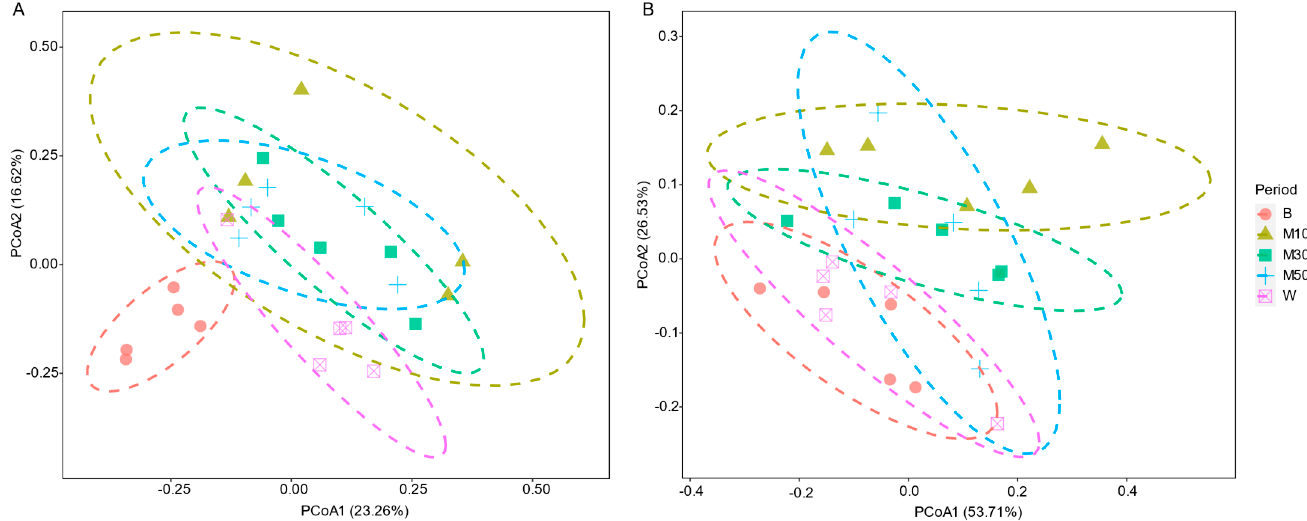
Figure 2. Bray-Curtis distance principal coordinate analysis (PCoA) of ruminal bacterial community successions following monensin treatment at the OTU level ( A ) and at the family level ( B ). The ellipses around each treatment group are of 80% confidence. Note: B, baseline period; M10, M30, and M50, on d 10, 30, and 50 of the treatment period; W, washout period.